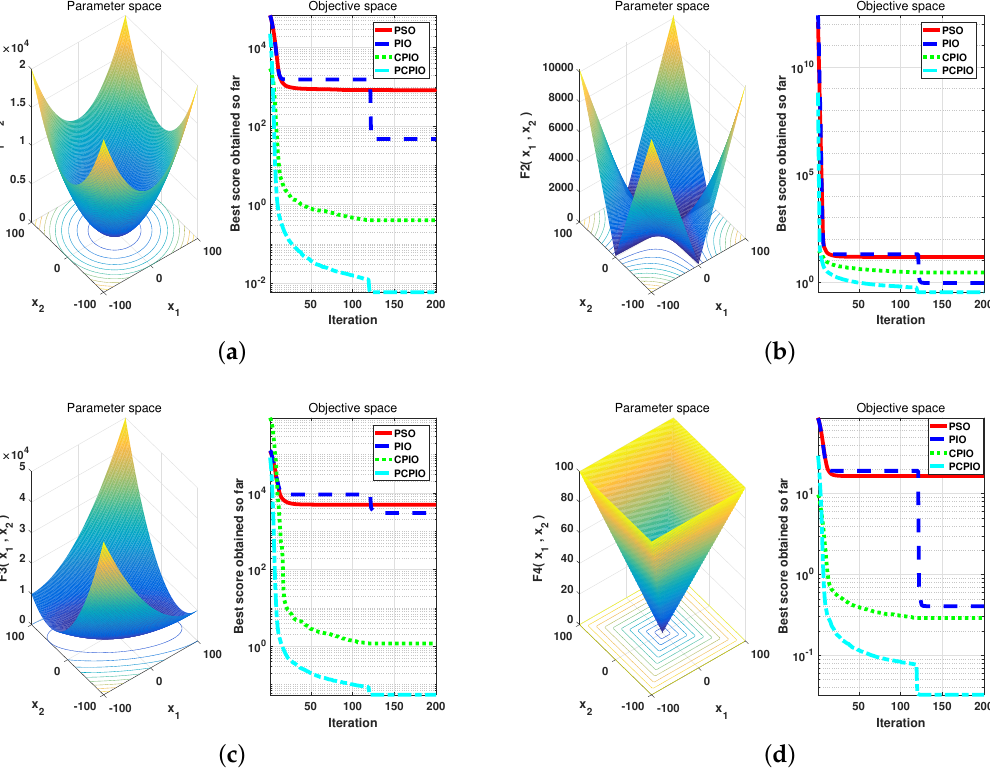
Figure 4. Comparison of running times of the PCPIO, with the CPIO, PIO, and PSO algorithms in the test functions. ( a ): f1 function, ( b ): f2 function, ( c ): f3 function, ( d ): f4